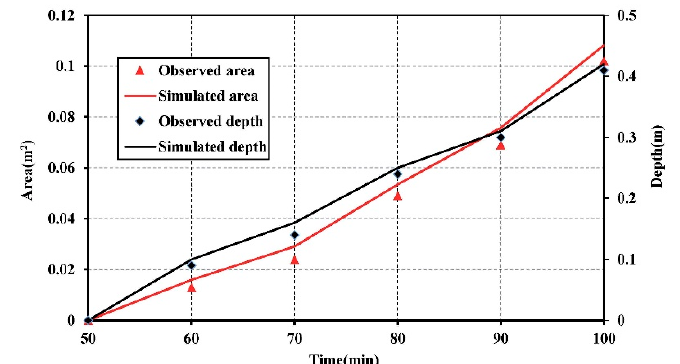
Figure 4. The observed and simulated seawater contamination plume area and maximum vertical pollution depth over time for scenario